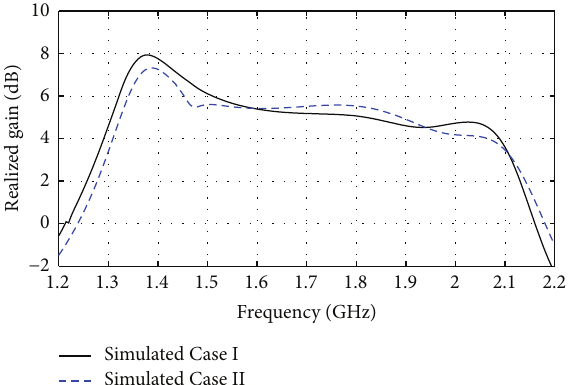
Figure 11: Realized antenna gain for both cases (Case I and Case II, as mentioned in Table 1), with 𝑎 = 32 mm, 𝑏 = 29.6 mm, 𝑑 = 48.85 mm, = 30 mm, 𝑊 = 5.3 mm, 𝐿 = 22 mm, 𝑊 = 1.5 mm,and 𝑀 𝐿 1 1 2 2 = 5 mm, and 𝐿 = 𝑊 = 130 𝑃 𝑑